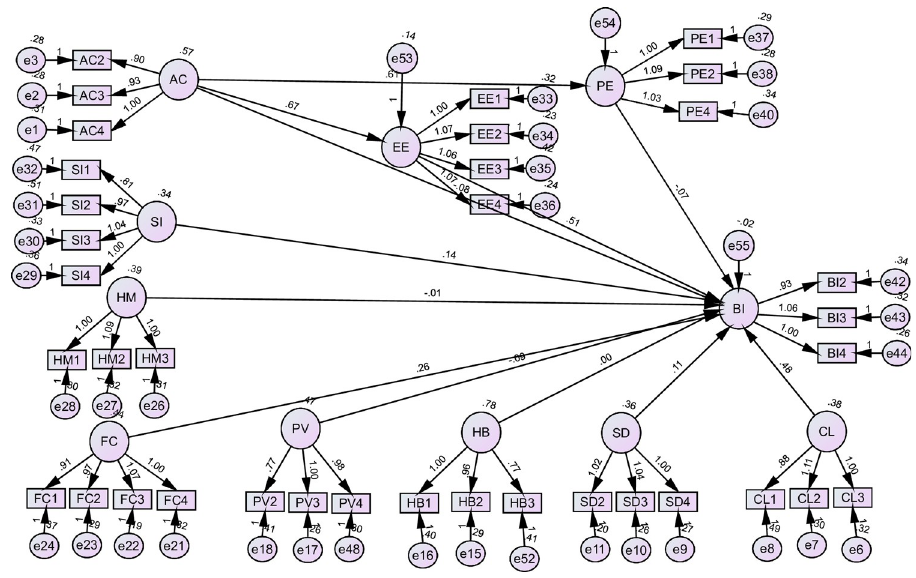
Fig 3. SEM analysis for Thailand.